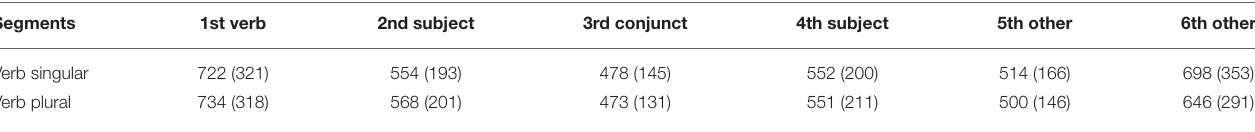
TABLE 2 | Adult reading times (in milliseconds) per segment in the postverbal subject condition (SDs in parentheses).